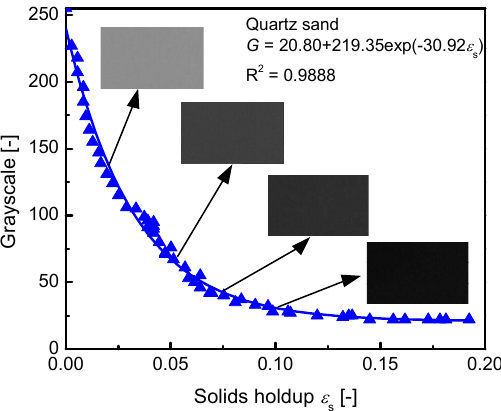
Figure 7. Calibration curve of solids holdup and image grayscale for Group A sand particles.